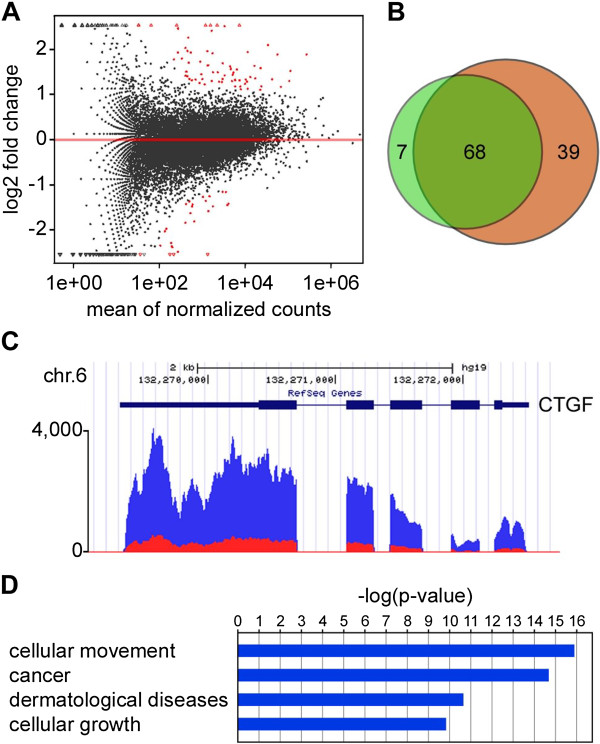
The transcriptome of the aging human epidermis. (A) MA plot showing fold change between young and old in relationship to the mean expression level. Red marks indicate genes with significant differential expression, as determined by DESeq analysis. (B) Venn diagram showing the overlap in differentially expressed gene sets, as determined by DESeq (green) and by Cuffdiff 2 (orange). (C) Connective Tissue Growth Factor (CTGF) is shown as a representative example for a differentially expressed gene. RNA-seq coverage is indicated for young (blue) and old (red) samples. (D) Ingenuity pathway analysis of differentially expressed genes. The plot shows the four most significantly enriched functional categories.